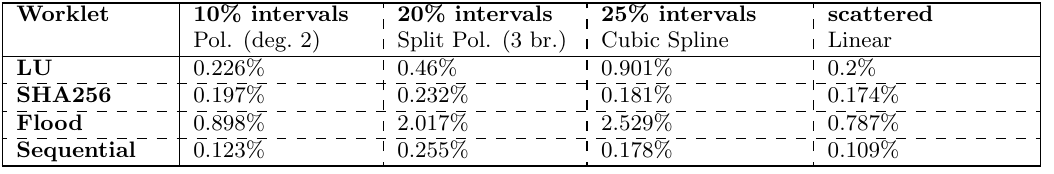
Table 3: Mean modeling errors of independent reference based interpolation for representative workloads. dataset features an improvement of 43.607% (mean